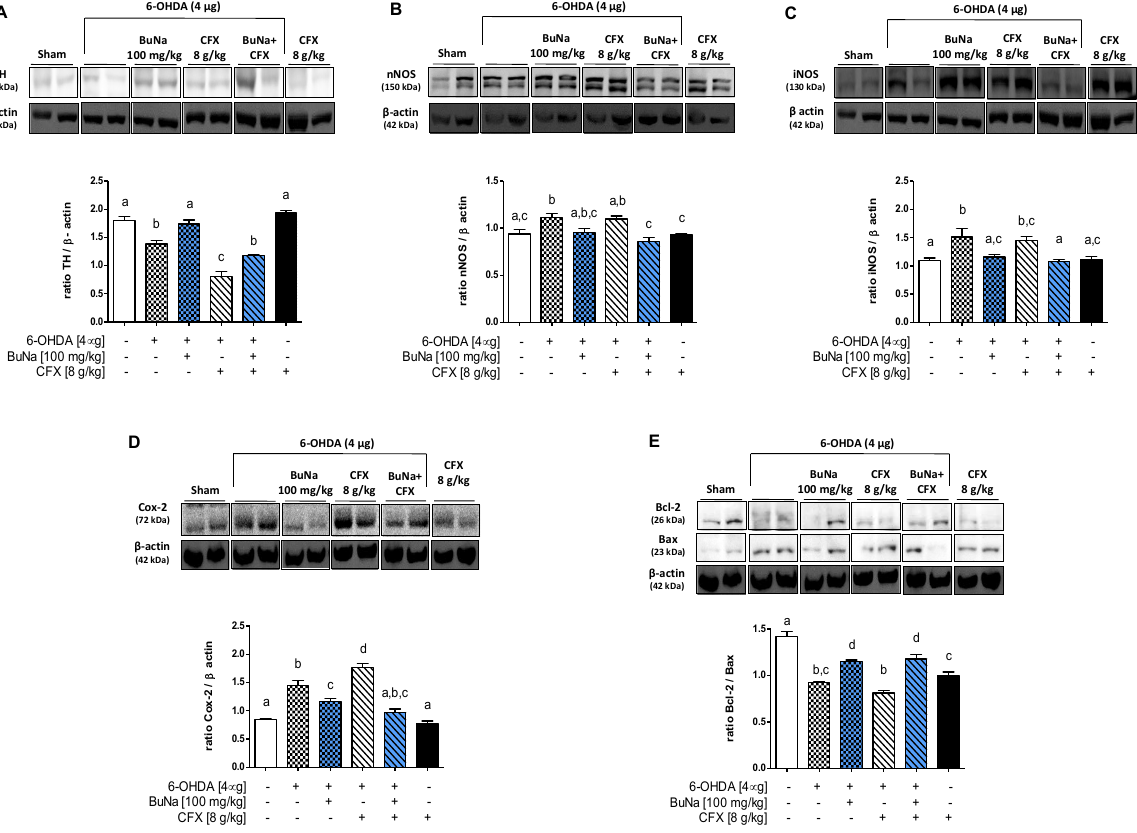
Figure 2. Neuroprotective effects of BuNa (100 mg/kg) measured using tyrosine hydroxylase, inflammatory and apoptotic markers in the striatum in mice: ( A ) TH ( B ) nNOS, ( C ) iNOS ( D ) COX-2, ( E ) Bcl-2 and Bax expression reported as the ratio of optical densities of their bands. Representative immunoblots of all tissues analyzed were shown. Densitometric analysis of protein bands is reported: the levels are expressed as the density ratio of target to control protein bands ( β -actin). Values are expressed as mean ± SEM ( n = 4–6). Labeled means without a common letter differ, p < 0.05. 2.3. Alteration of Systemic Pro-Inflammatory Markers. Protective Effect of BuNa Neuroinflammation has been associated with the progression and severity of PD. In parallel, inflammatory cytokines were elevated at the systemic level (Figure 3). 6-OHDA mice showed a significant increase in serum TNF- α , IL-1 β , and IFN- γ compared to Sham mice (Figure 3A–C), and levels of those cytokines, except for IL-1 β , were even